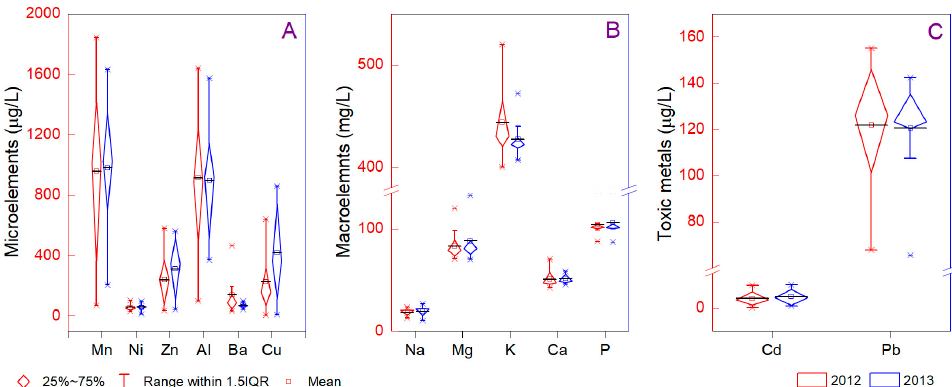
Figure 2. The distribution of microelements ( A ), macroelements ( B ), and toxic elements ( C ) of 2012 and 2013 wine samples. Comparatively, the values from 2012 (red) and 2013 (blue) are